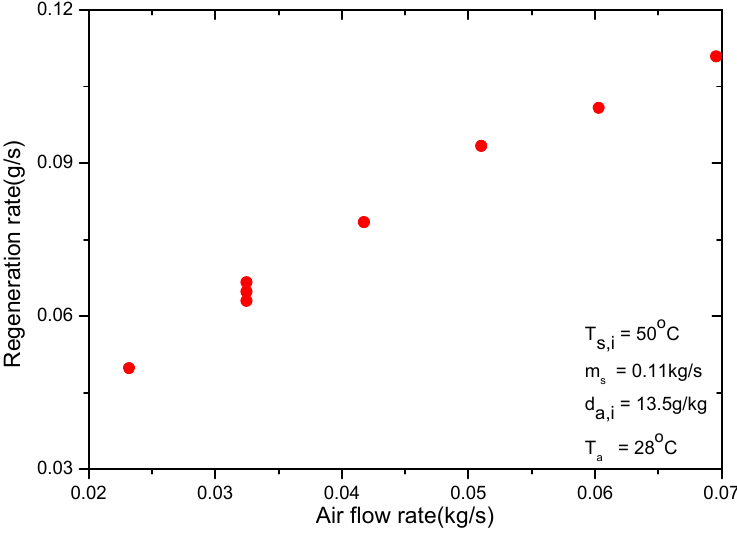
Figure 3. Influence of air flow rate on